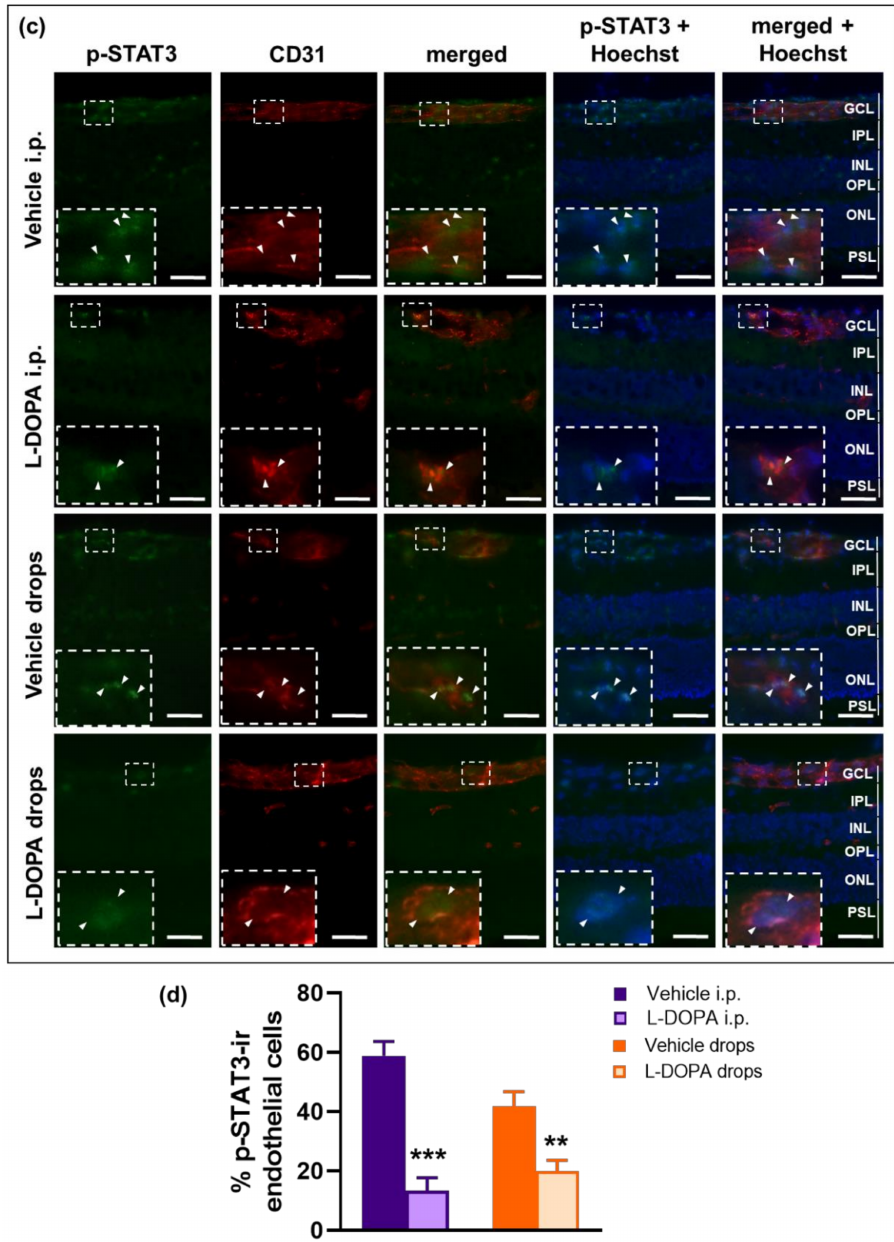
Figure 10. EAU Gnat1 rd17 mice show decreased p-p65 and p-STAT3 expression in retinal endothelial cells after L-DOPA treatment. Representative transverse retinal sections of EAU Gnat1 rd17 mice (day 14 after immunization) treated with vehicle or L-DOPA given i.p. or topically as eye drops were co-immunolabeled for ( a ) p-p65 (green) or ( c ) p-STAT3 (green) and CD31 (red) to stain endothelial cells. Hoechst staining (blue) indicates nuclei. The scale bar is 50 µ m. Insets show higher magnifica- tion of p-p65-immunoreative (p-p65-ir) or p-STAT3-immunoreactive (p-STAT3-ir) endothelial cells (marked with arrowheads). Bar graphs show the mean percentage of ( b ) p-p65-ir or ( d ) p-STAT3-ir endothelial cells per total number of endothelial cells within one section. The data are expressed as the mean ± SEM of 6 retinas from 6 animals per group. ** p < 0.01 by paired t -test for comparisons between groups of vehicle-treated contralateral eyes and L-DOPA-treated ipsilateral eyes in the same animals, and *** p < 0.001 by unpaired t -test for comparisons between groups with i.p. injection of vehicle and L-DOPA. GCL, ganglion cell layer; IPL, inner plexiform layer; INL, inner nuclear layer; OPL, outer plexiform layer; ONL, outer nuclear layer; PSL, photoreceptor segment